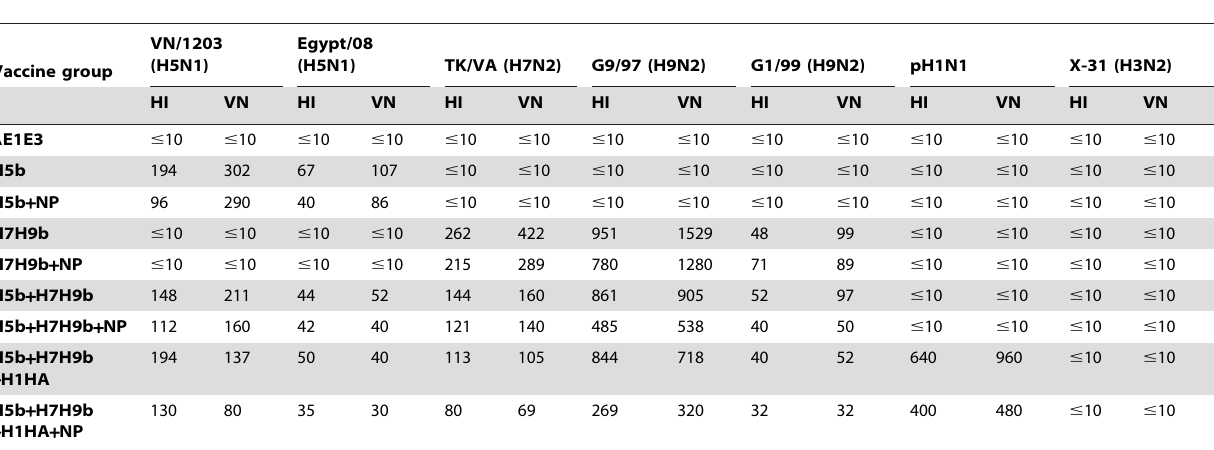
Mice (7 animals/group) were immunized with H5b, H7H9b, H5b + H7H9, H5b + H7H9b + H1HA, H5b + NP, H7H9b + NP, H5b + H7H9b + NP, H5b + H7H9b + H1HA + NP, or D E1E3 twice at 4 week intervals. Four weeks post-booster inoculation, serum samples were obtained for determining virus neutralizing (VN) and hemagglutination inhibition (HI) antibody titers. The data are shown as the geometric mean titers. H5b, HAd-1203HA-05HA; H7H9b, HAd-H7HA-H9HA; H5b + H7H9b; HAd-1203HA-05HA + HAd-H7HA- H9HA; H5b + H7H9b + H1HA, HAd-1203HA-05HA + HAd-H7HA-H9HA + HAd-H1HA; H5b + NP, HAd-1203HA-05HA + HAd-NP; H7H9b + NP, HAd-H7HA-H9HA + HAd-NP;